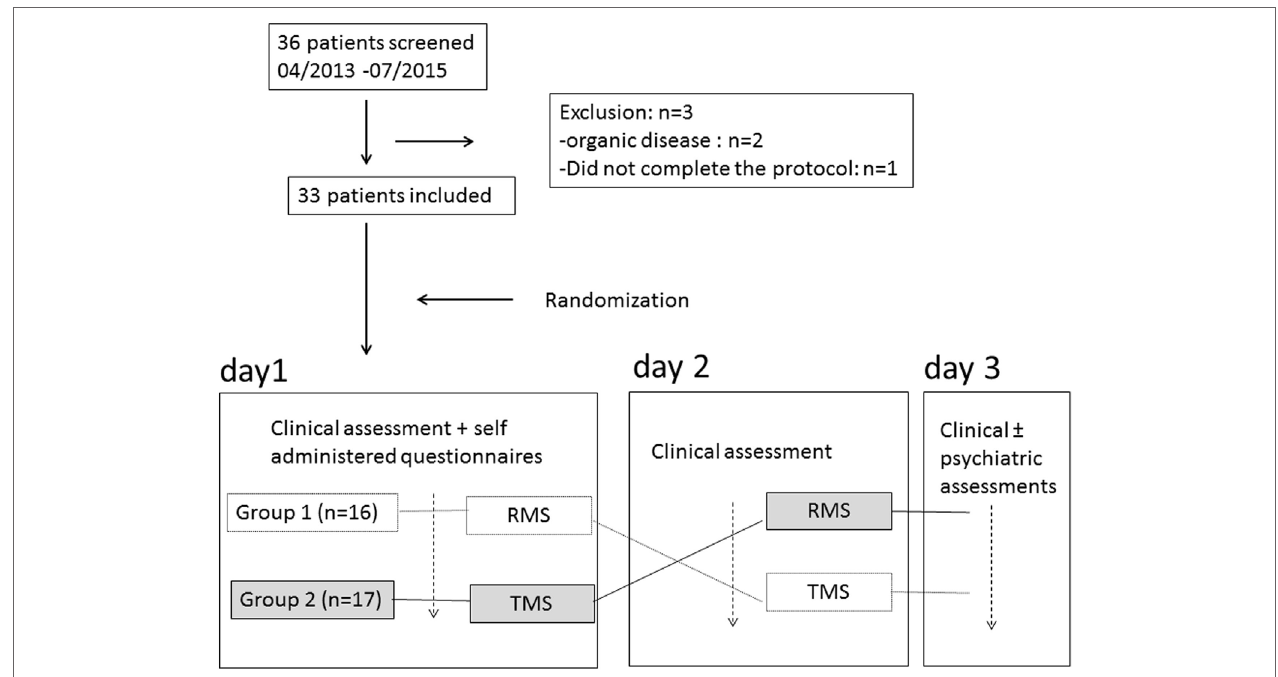
FigUre 1 | Study design. RMS, root magnetic stimulation; TMS, transcranial magnetic